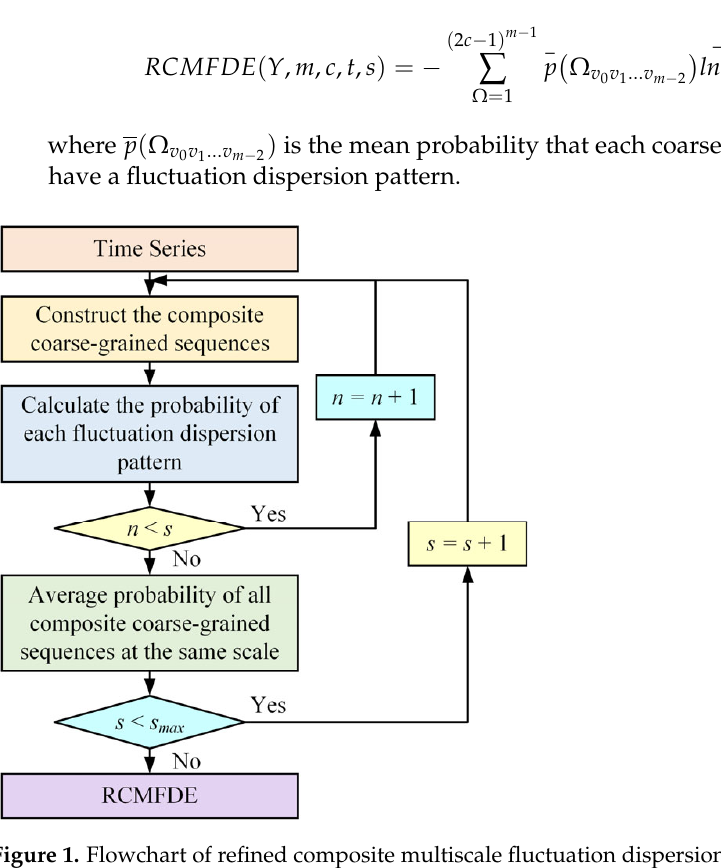
Figure 1. Flowchart of refined composite multiscale fluctuation dispersion entropy (RCMFDE).